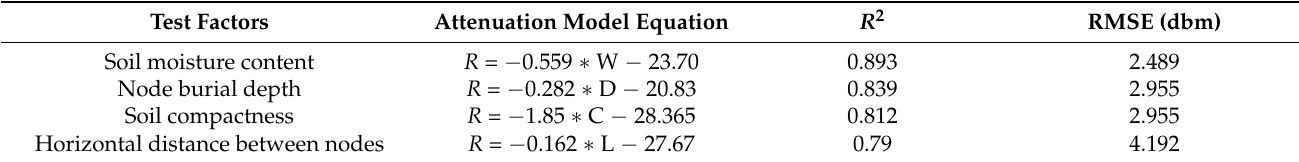
Table 3. Specific data of single-factor attenuation